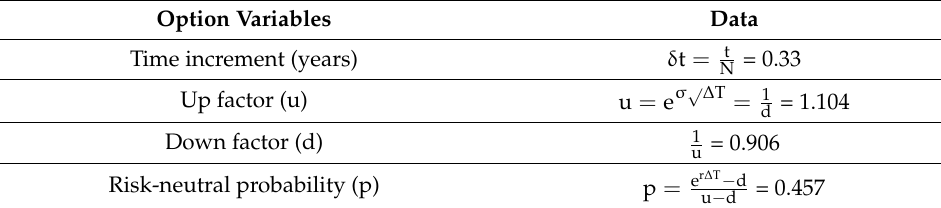
Table 5. Parameters of the Binominal Option Pricing Model lattices.